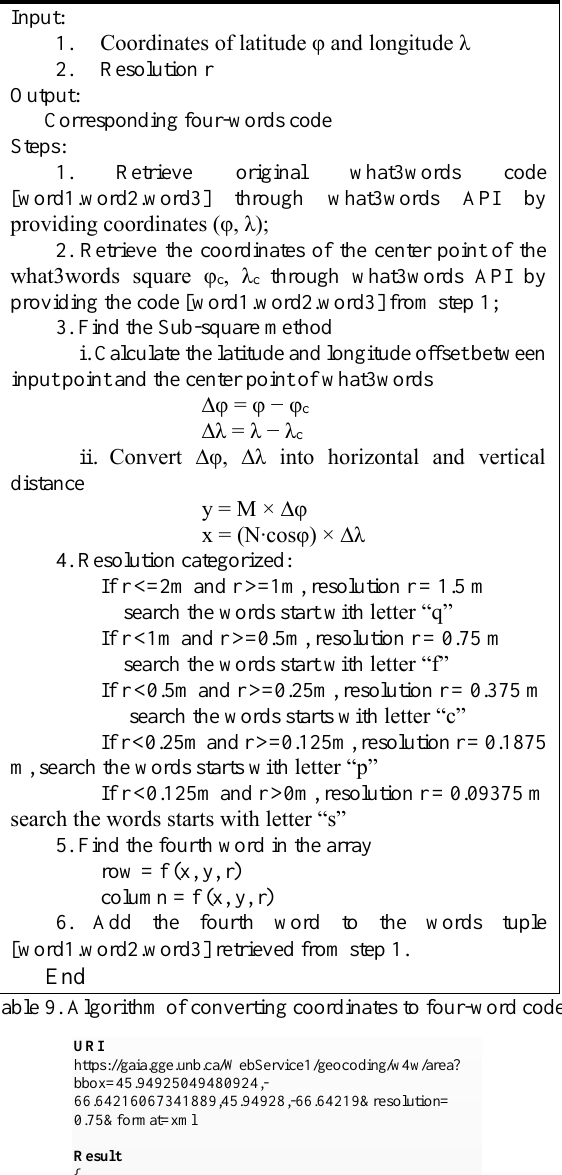
Algorithm 2: Reverse geocoding, from position to four-